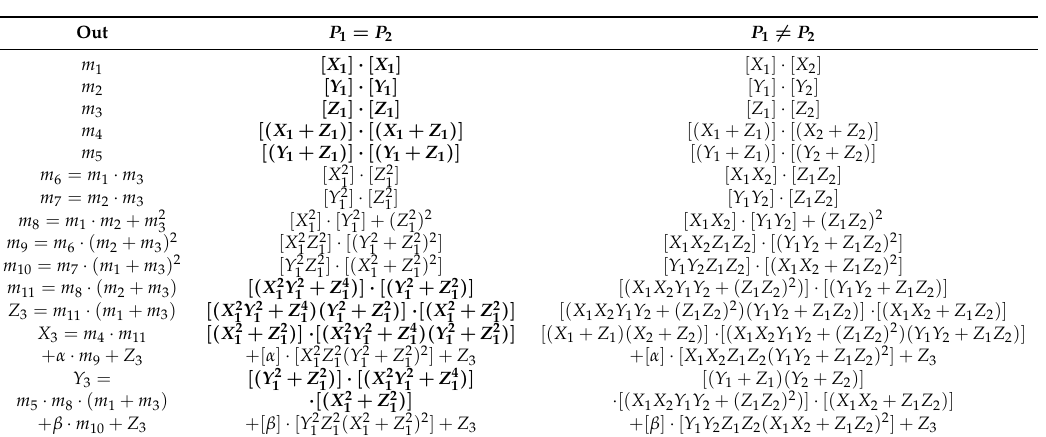
Table 1. Unified point addition on binary Huff